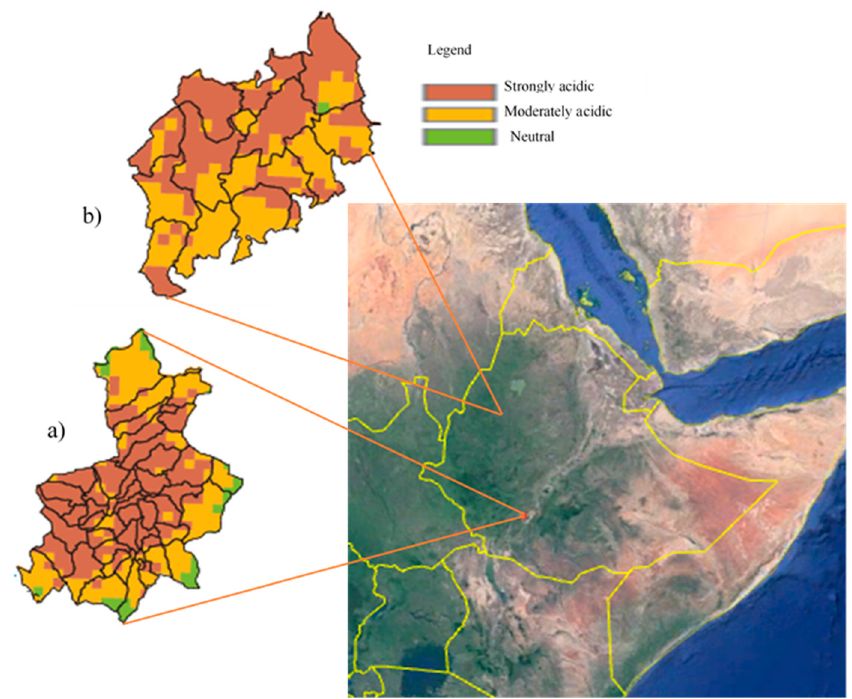
Figure 7. Map of soil pH for ( a ) Chencha district (Southern Nations, Nationalities, and Peoples’ Regional State, Ethiopia), and ( b ) Guagusa Shikudad district (Amhara Regional State, Ethiopia). Reproduced with kind permission from the Ethiopian Agricultural Transformation Agency [13].